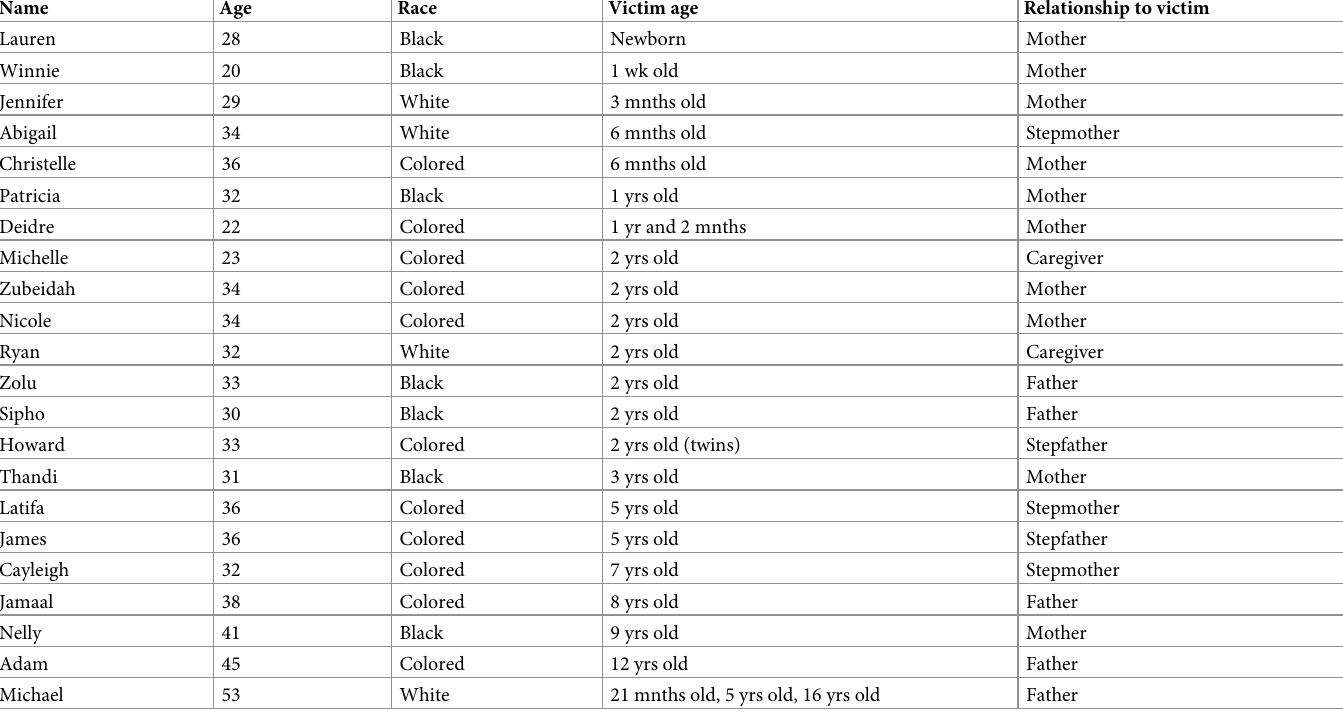
Table 1. Sample characteristics using